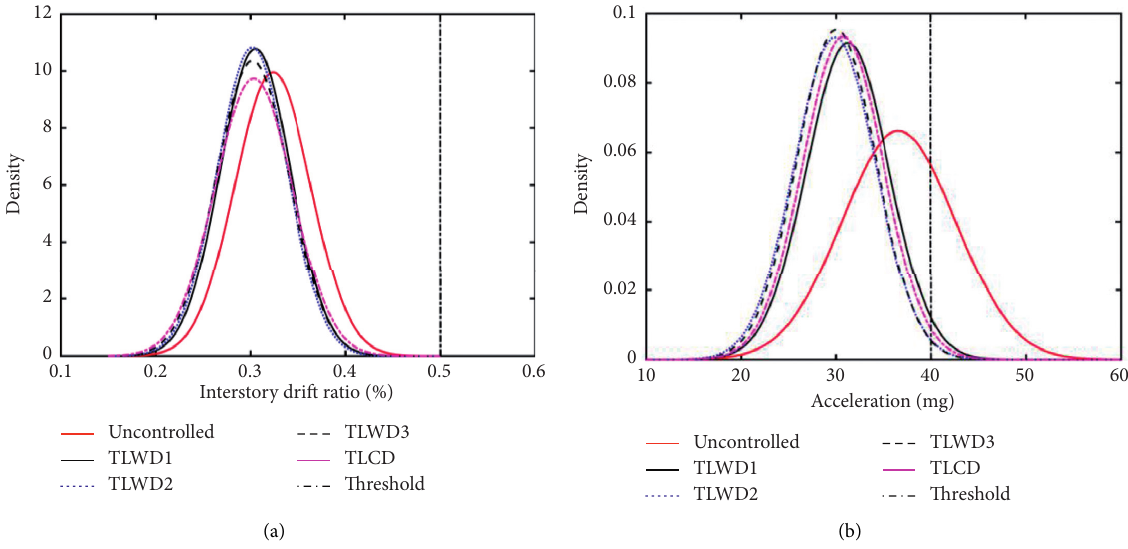
Figure 14: Distribution of maximum absolute responses using TLWDs arranged over the last 15 floors: (a) interstory drift ratio and (b) acceleration.